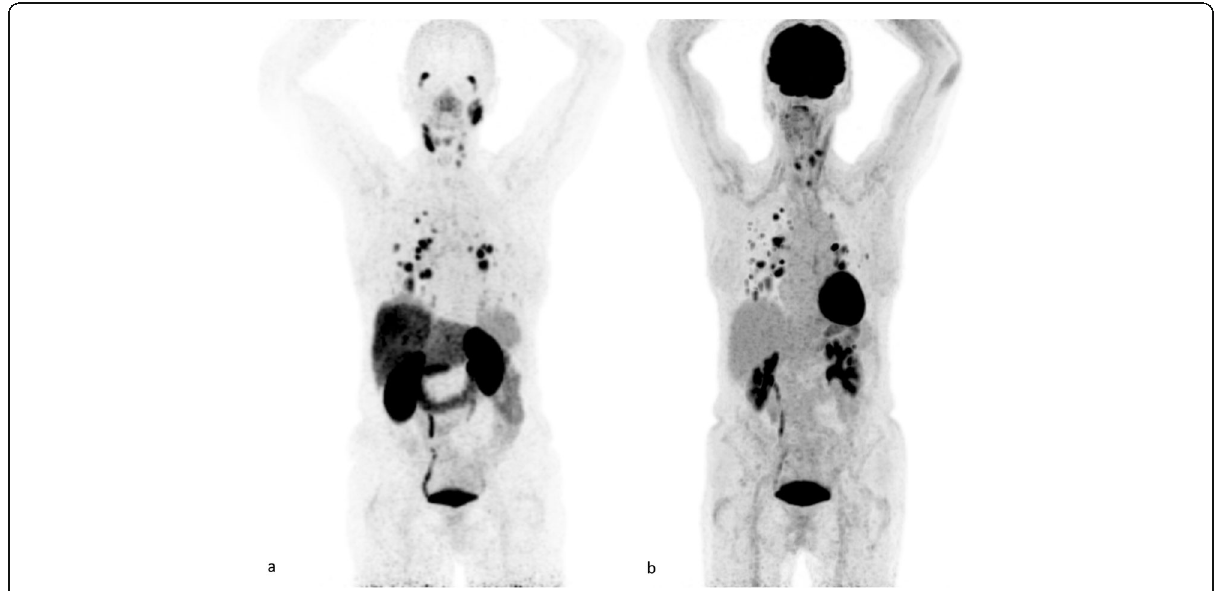
Fig. 2 Images of patient 2. a Maximum intensity projection of 68 Ga-PSMA PET/CT. b Uptake in multiple pulmonary metastases and cervical lymph nodes on 18 FDG